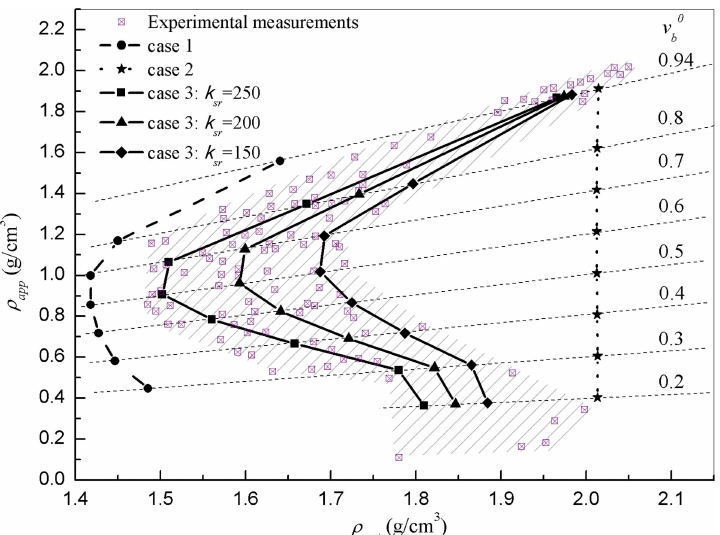
Fig 6. Tissuedensity ( ρ mat ) vsapparentdensity( ρ app ) of bone for differenttemporalresorption conditions (initial bonevolumes v 0 rangingfrom0.2 to 0.94)superimposed with experimental measurements[13]. b Theplotpresents the valuesat equilibriumstate( ξ = ξ * , t = 8000days).Case-1(dashedlinewithcircles):res- orptionof boneis independent ontemporalhistoryandit isaveragedthroughallthevolume,including the most mineralizedsub-volumes. Thisleadsoverallto the lowestmaterialtissuedensitiesfor allthestartingconditionswe examine.Case-2(dottedlinewithstars): resorptionis onlyallowedto happenatthe newlycreatedbone,collapsing thecurveto a verticallinewhereallbonevolumeisfullymineralizedregardless v 0 . Case-3:resorptionislimitedto b temporal windows(bonepartscreatedbetween T nm and T sr + T nm daysago),withthreevaluesof κ sr : 150(solid linewithdiamonds),200(solidlinewithtriangles)and250(soliddashedlinewithsquares). The introductionofthe hypothesisthat resorptionappliesnot justonnewlycreatedbonecompartmentsbut to recently formedboneupto 250days,shiftsthe curvesproducinganenvelopewhichpractically coversthe completeexperimentallyobserved datasetof